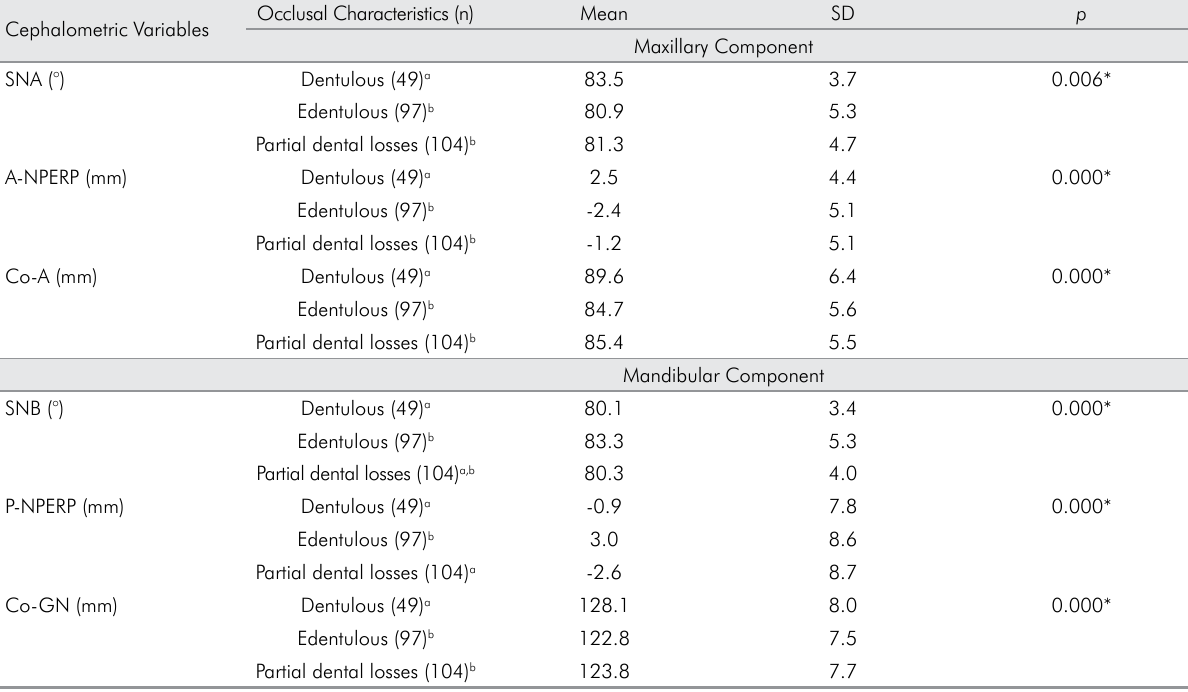
Table 6. Comparison between the occlusion pattern and the variables of maxillary component, mandibular component, and maxillomandibular relationship: Mean, Standard Deviation (SD), ANOVA ( p